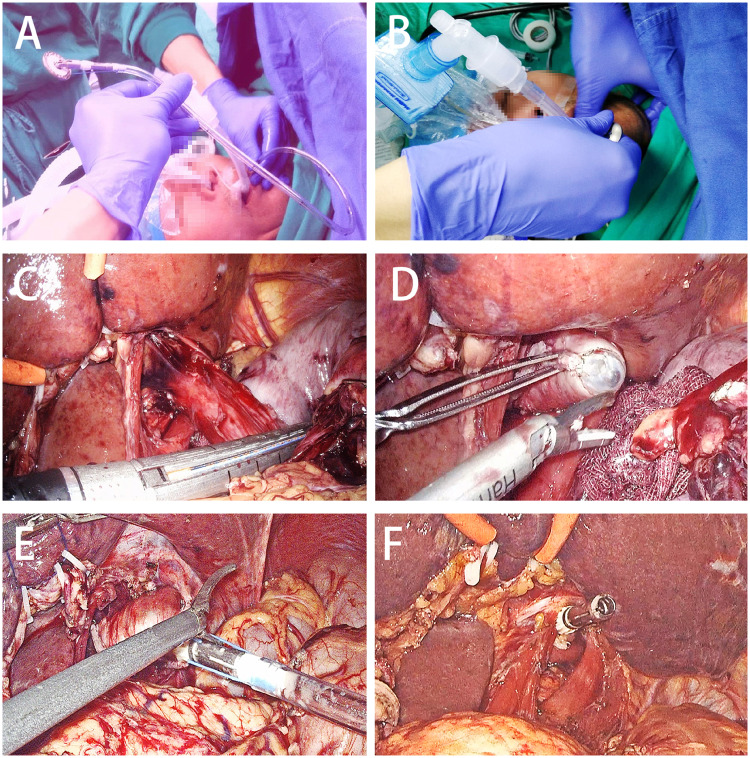
The key course of anvil insertion using the DST seriesTM EEATM OrVilTM. (A) and (B) OrVilTM anvil was inserted transorally by anaesthetists. (C) The distal oesophagus was transected using a linear stapler. (D) A small cavity was made at the left edge of the staple line in the esophageal stump with a harmonic scalpel. (E) and (F) After the central rod of the anvil was extracted and completely exposed, the tube was dislinked from the anvil by cutting the connecting thread and then taking it away from the abdomen.